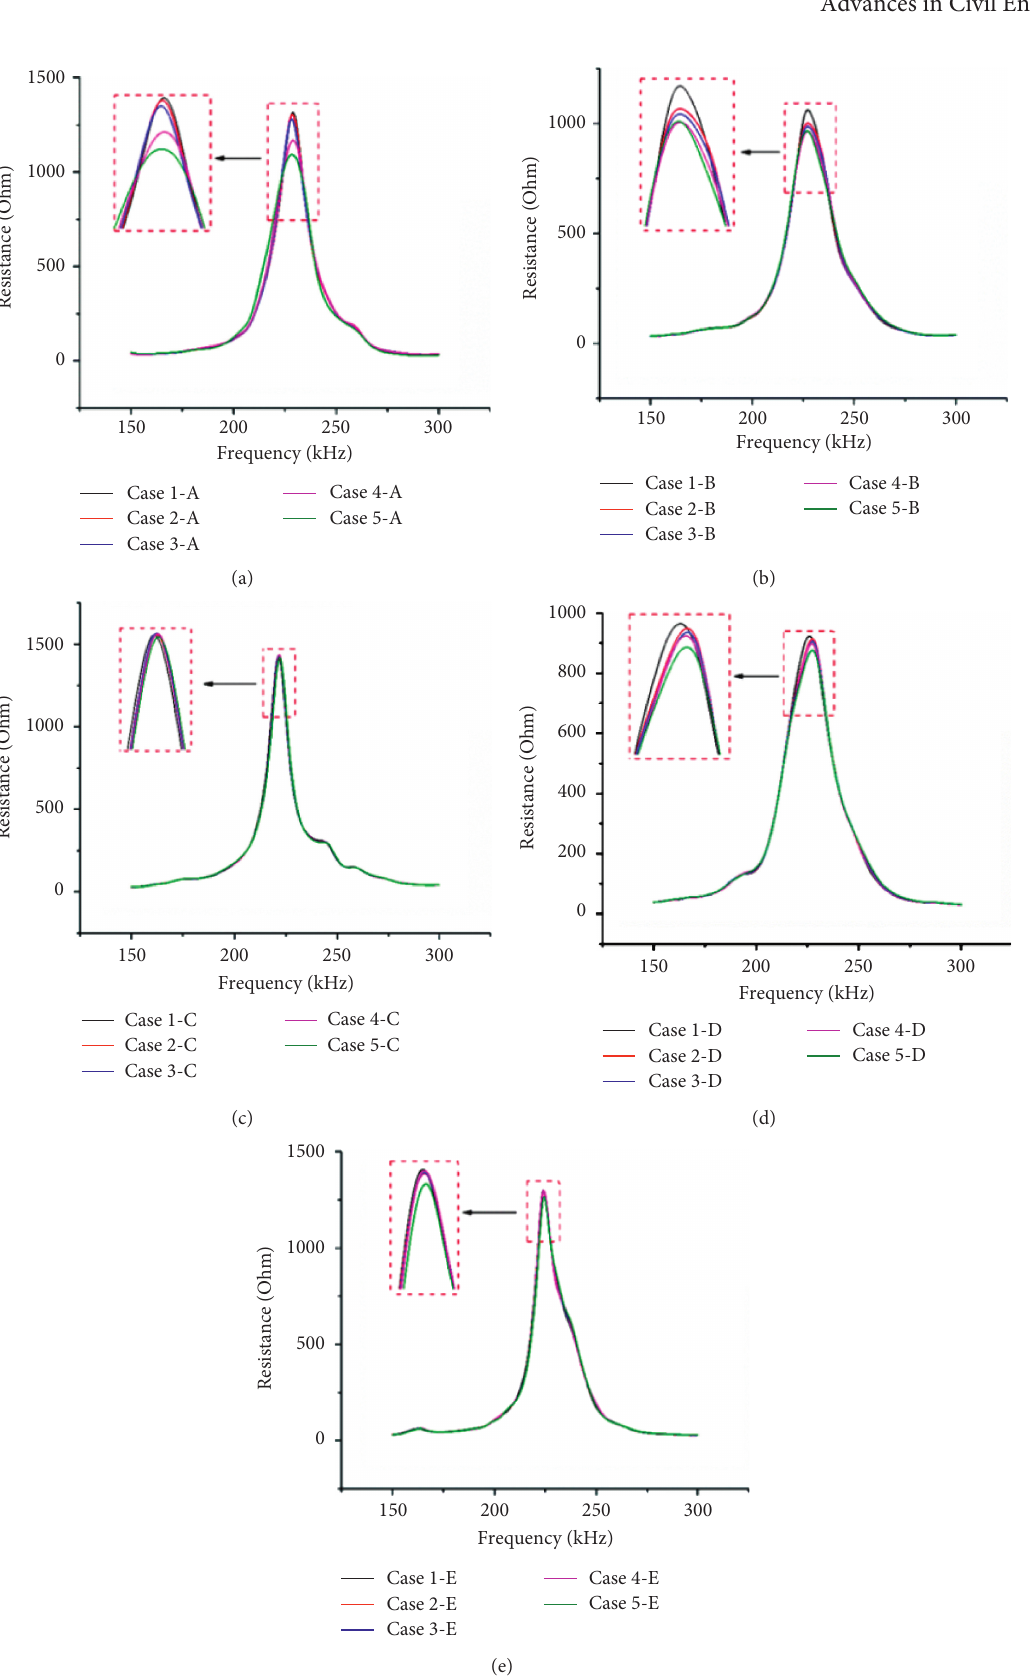
Figure 7: Impedance signatures in different cases from 150kHz to 300kHz. (a) Cases 1–5 in Group A; (b) Cases 1–5 in Group B; (c) Cases 1–5 in Group C; (d) Cases 1–5 in Group D; (e) Cases 1–5 in Group